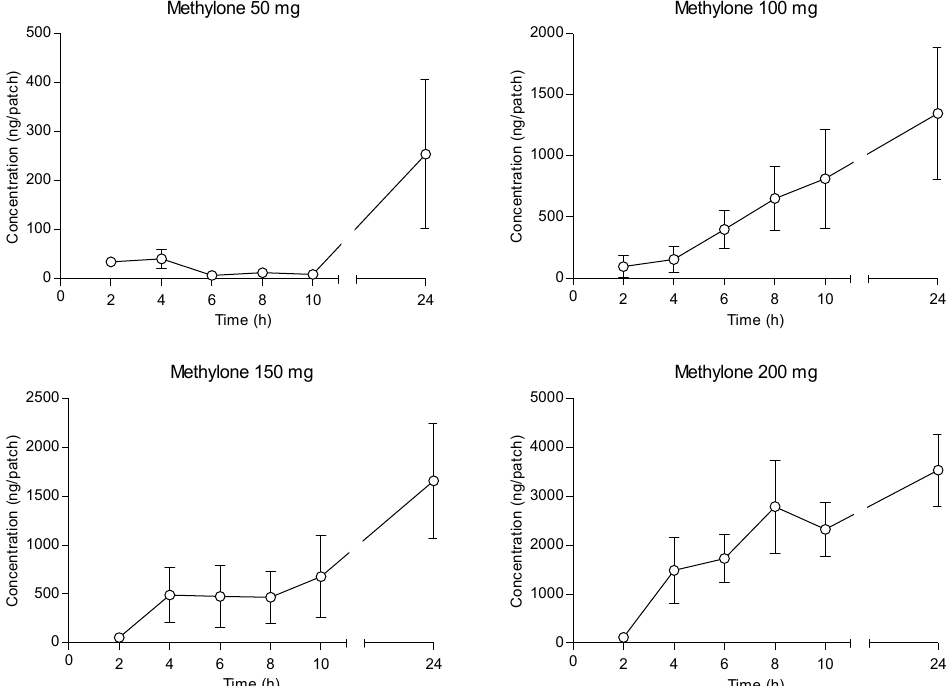
Figure 1. Mean concentration–time profiles of methylone contained in sweat patches following increasing controlled administrations (50, 100, 150 and 200 mg).